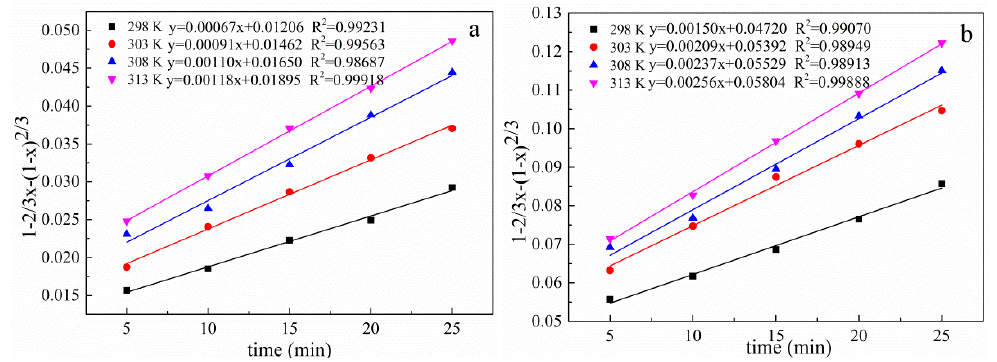
Figure 19. Plot of 1 − 2/3 x − (1 − x) 2/3 versus time for different temperatures under conventional and ultrasonic conditions. ( a ): under conventional conditions; ( b ): under ultrasonic conditions.